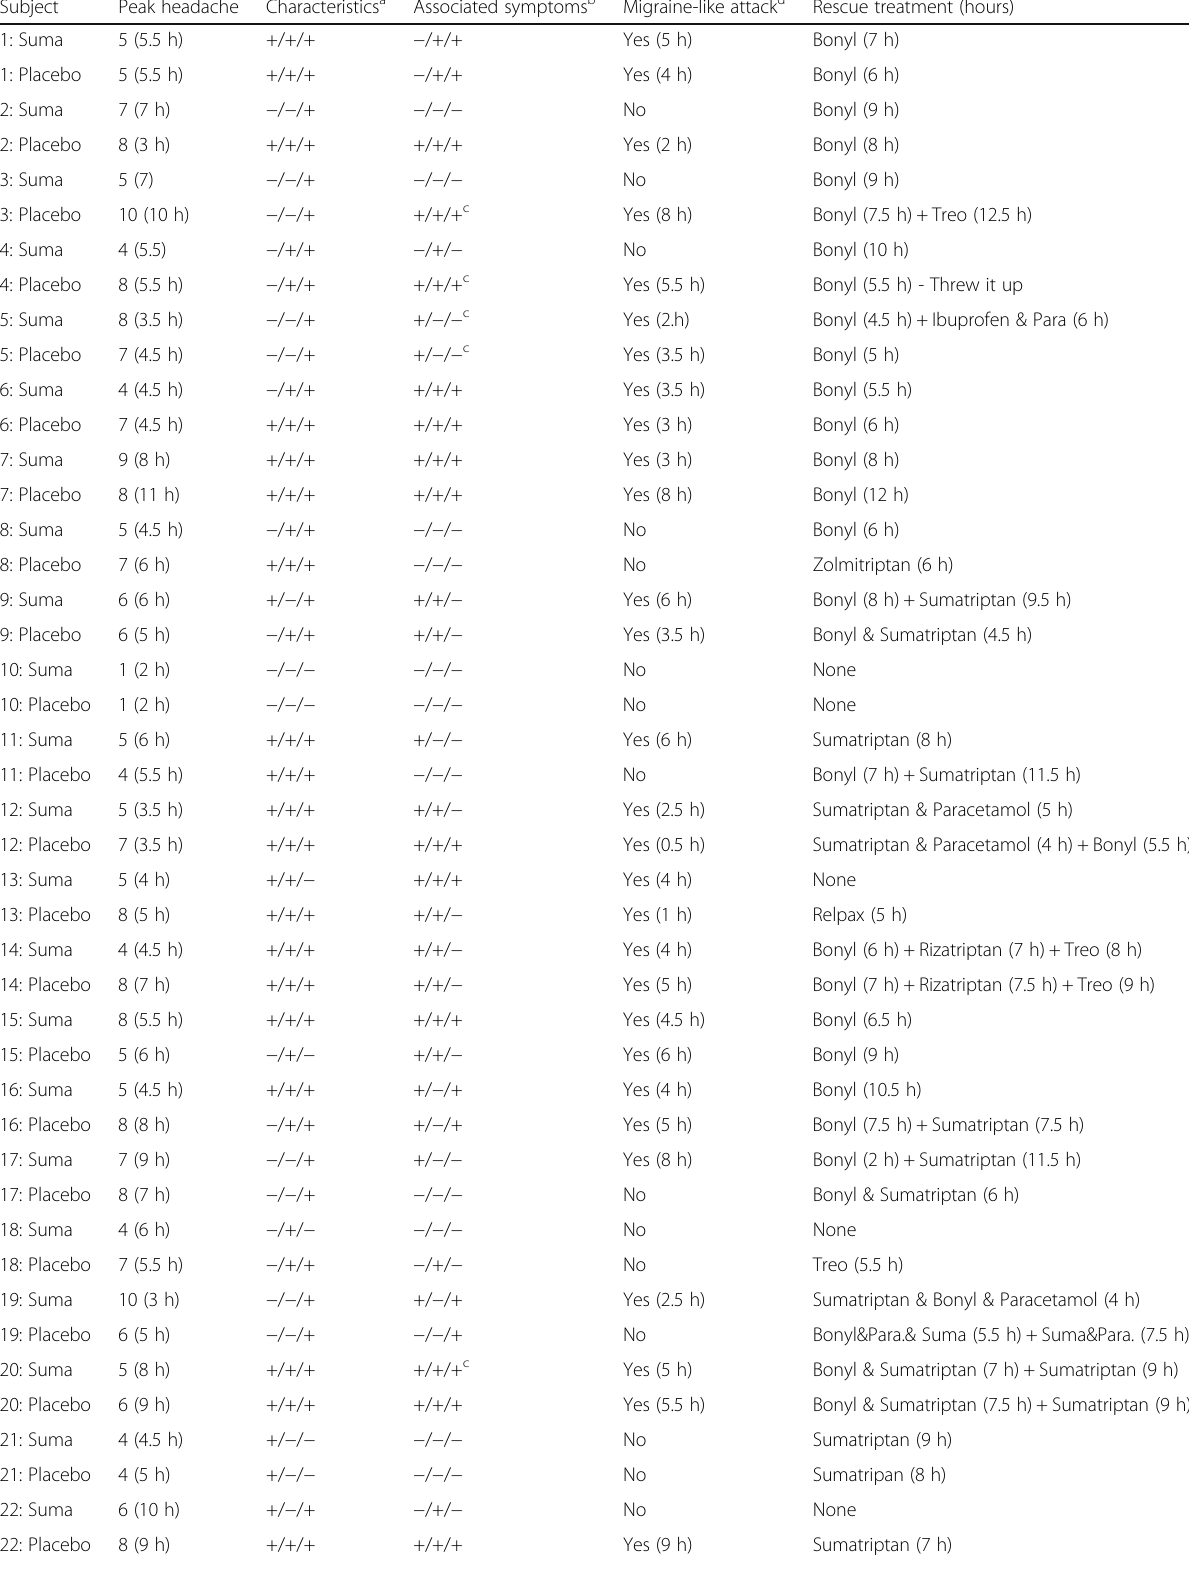
Table 2 Characteristics of the headache for each